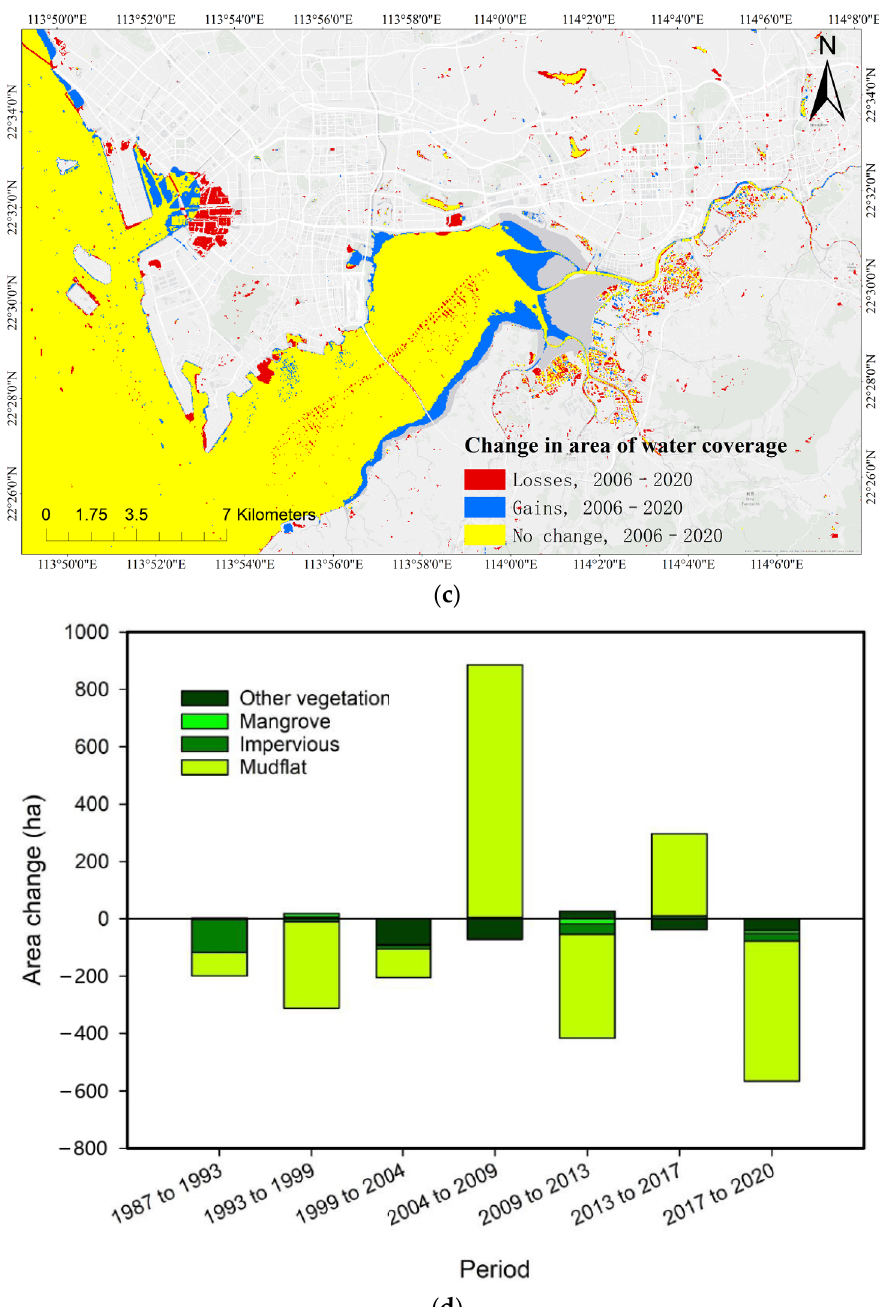
Figure 9. Water coverage in Deep Bay from 1987 to 2020. ( a – c ) Change detection maps; and ( d ) Change detection statistics of water coverage and other land cover types.